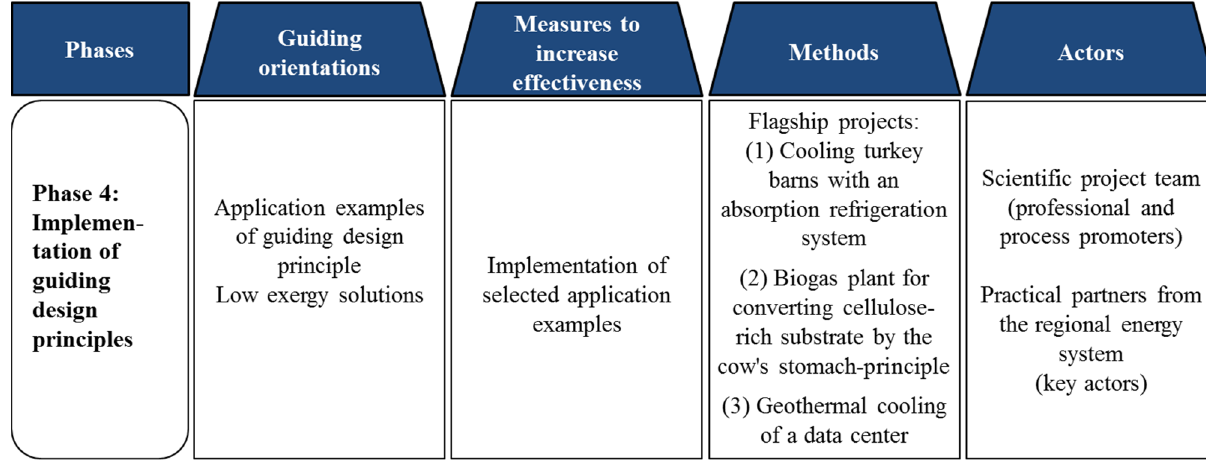
Figure 6. Phase 4 of the regional guiding orientation